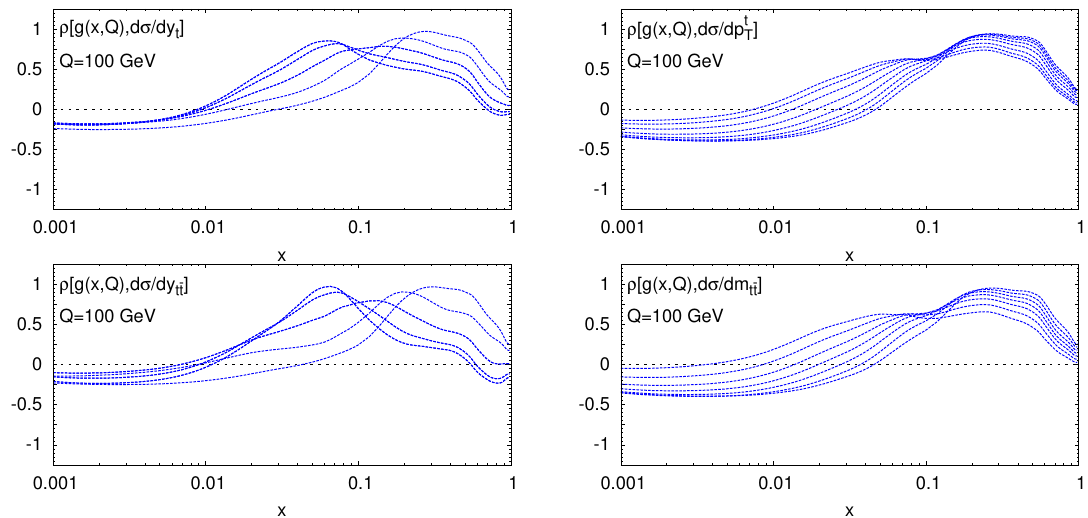
Figure 3 . The correlation coe(cid:14)cient (cid:26) between the gluon g ( x; Q 2 ), evaluated at Q = 100 GeV, and each of the bins of the y t , p t